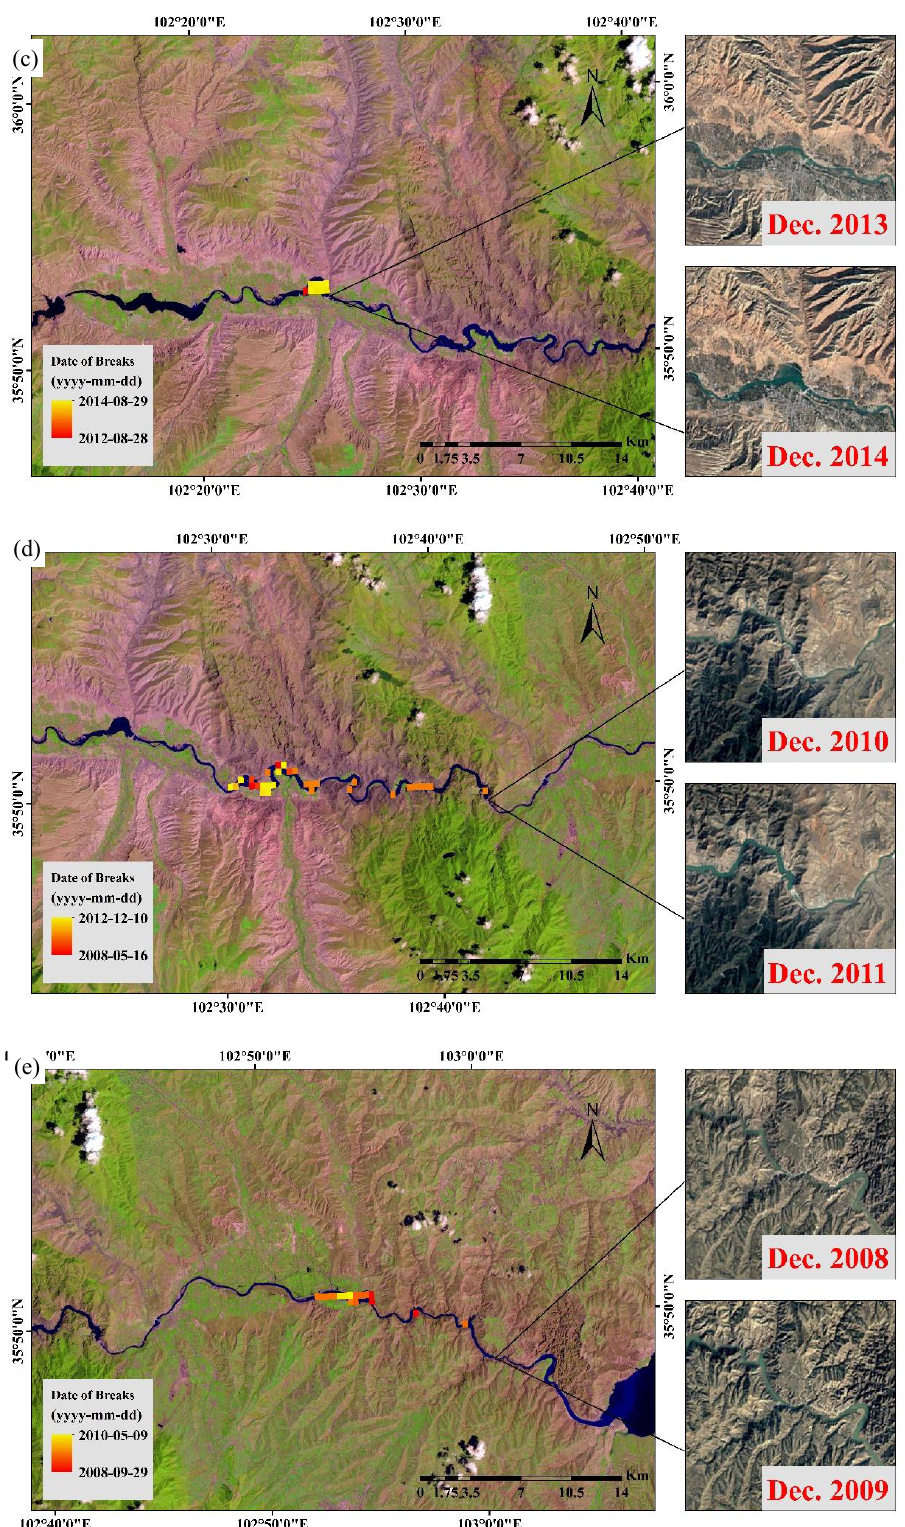
Figure 6. Spatial locations and extents and damming dates of true break points detected in Gongboxia Reservoir ( a ), Suzhi Reservoir ( b ), Huangfeng Reservoir ( c ), Jishixia Reservoir ( d ), and Sigouxia Reservoir ( e ). They showed the high consistency of locations of pixels detected as true break points and the timing of true break points which correspond to damming dates indicated by Google Earth imagery and documentary materials. The lines in the figures point at the location of